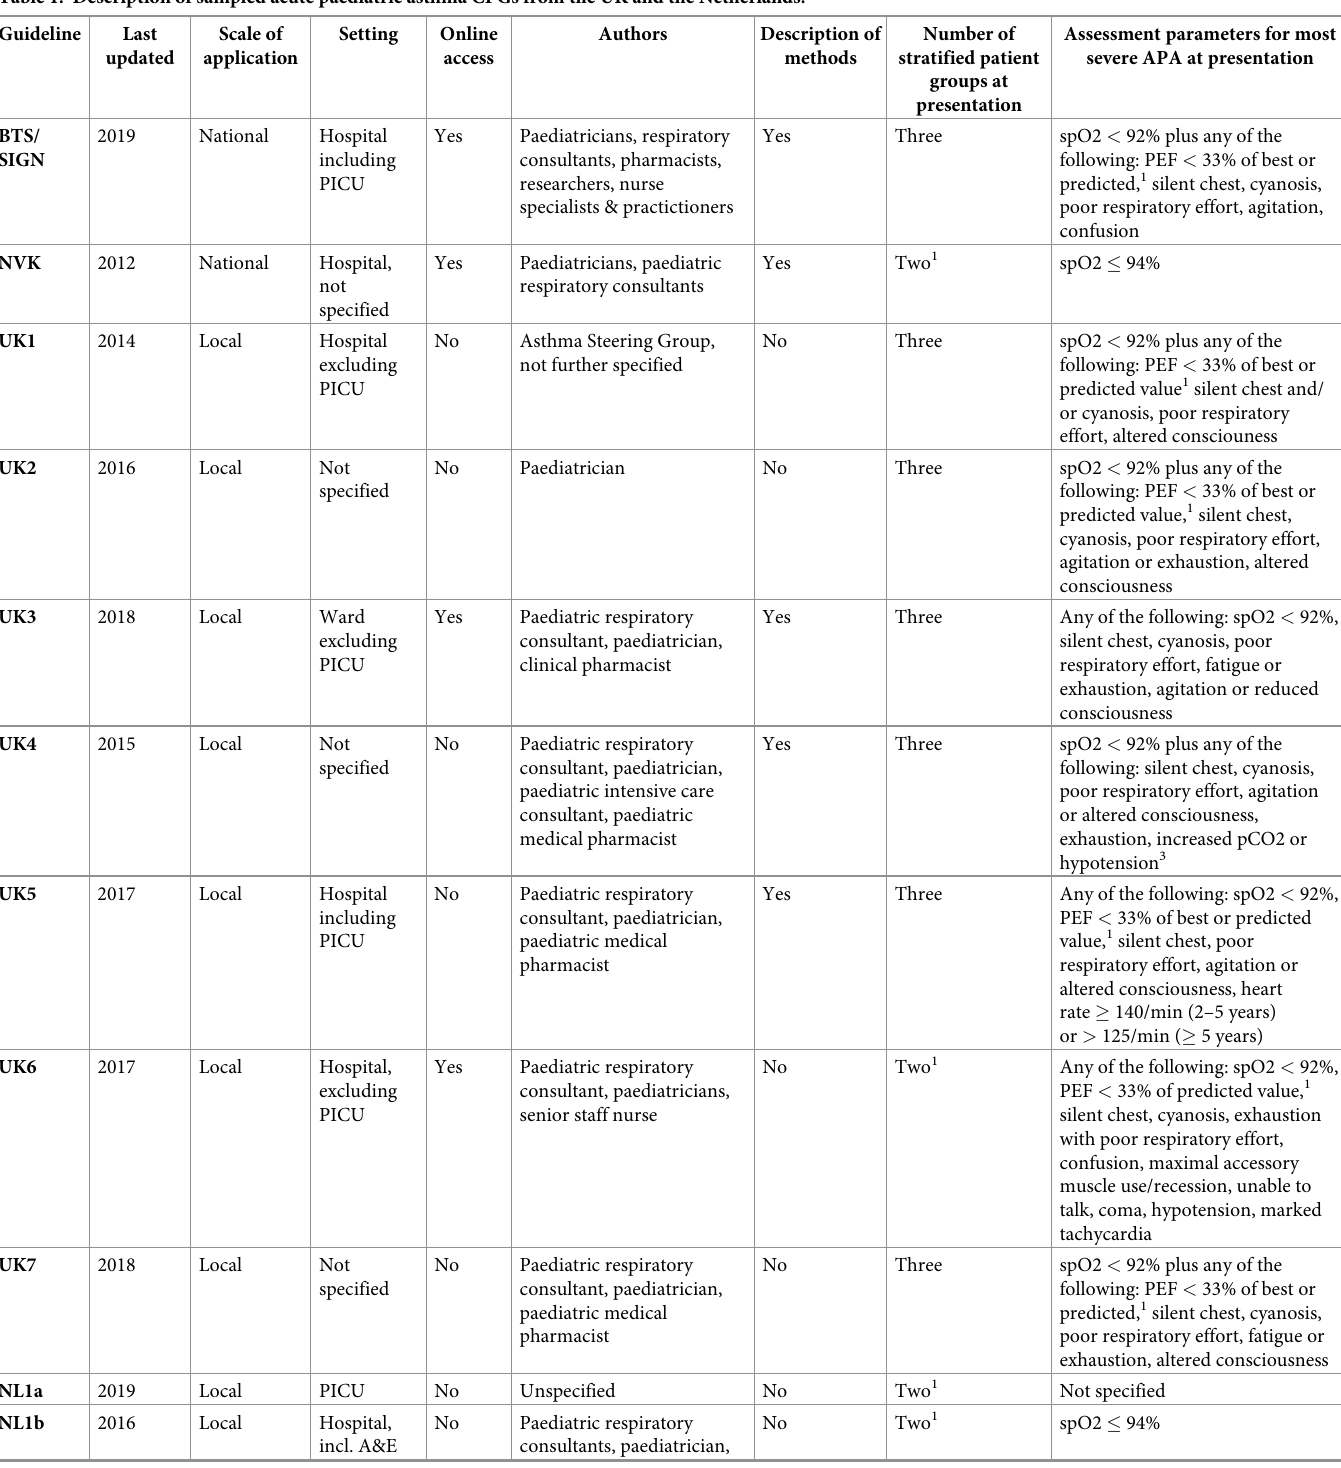
Table 1. Description of sampled acute paediatric asthma CPGs from the UK and the Netherlands.